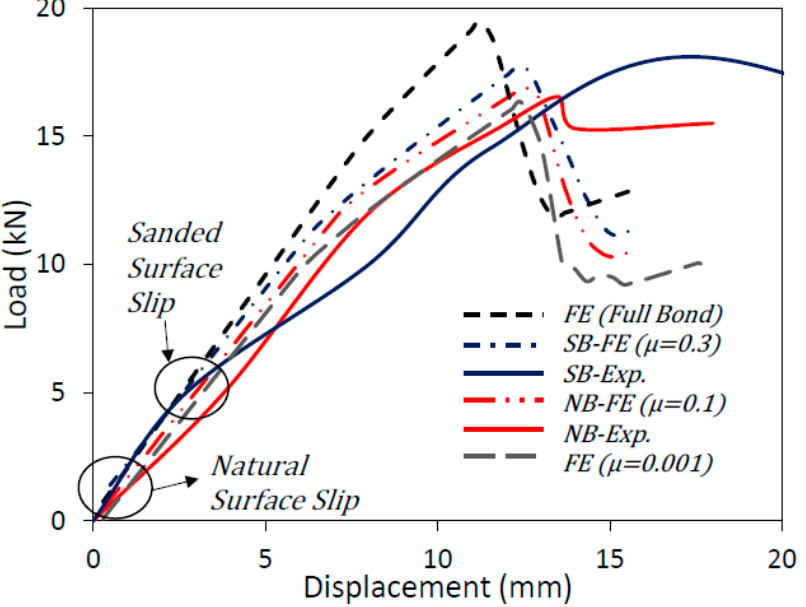
Figure 4. Load-deflection capacity of hybrid beams with assigned contact friction coefficients ( µ ).